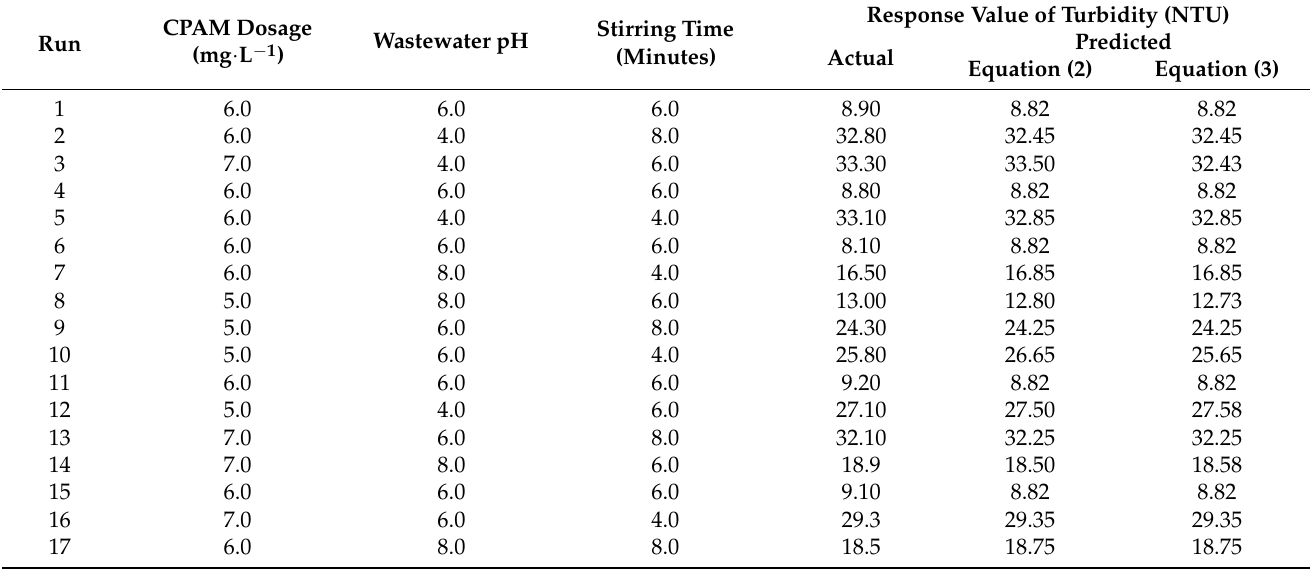
Table 3. The actual response values and predicted response values of BDD